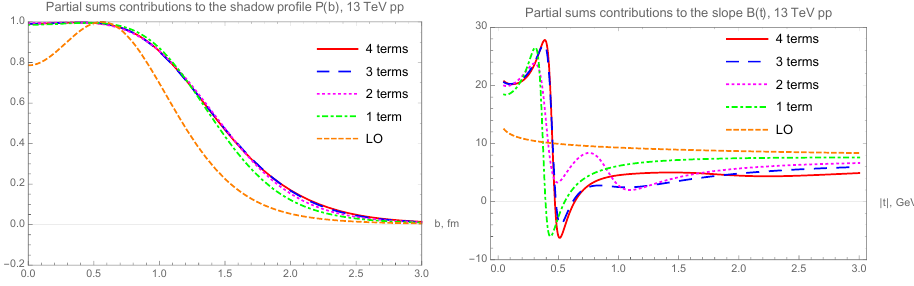
Figure 3. The shadow profile (left) and the elastic slope (right) with partial sums from leading order to fourth order Levy expansion, fitted to the TOTEM data at √ s = 13 TeV pp elastic